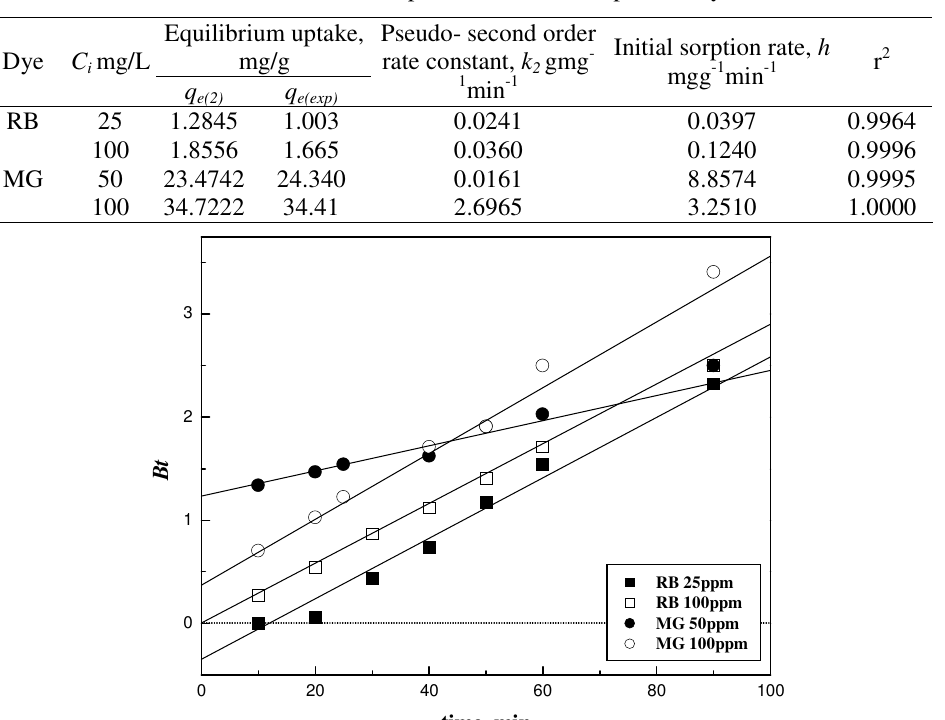
Figure 4. t versus Bt plots for the adsorption of dyes at different